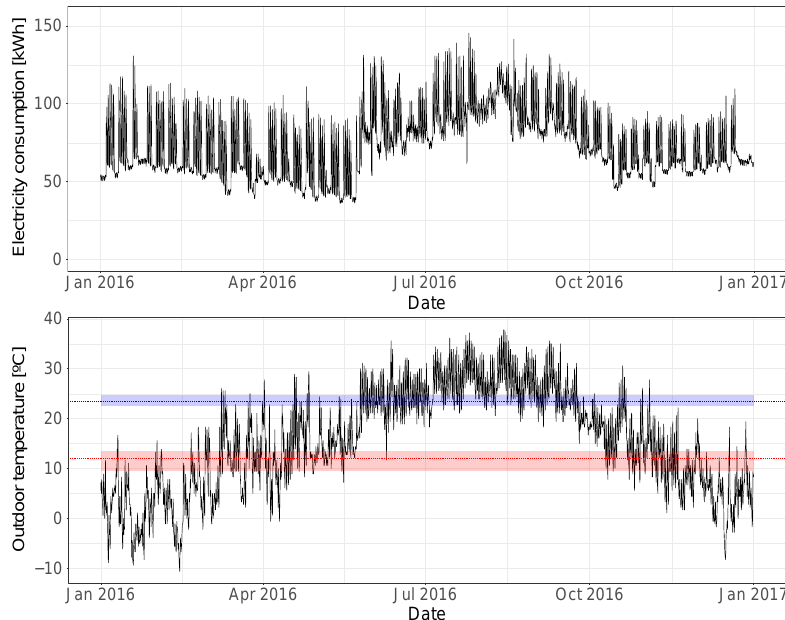
Figure 17. Electricity time-series vs. outdoor temperature values for the building Rat_education_Royal . The heating and cooling change-point temperatures estimated by the model are shown in red and blue with the corresponding 94% HDIs.